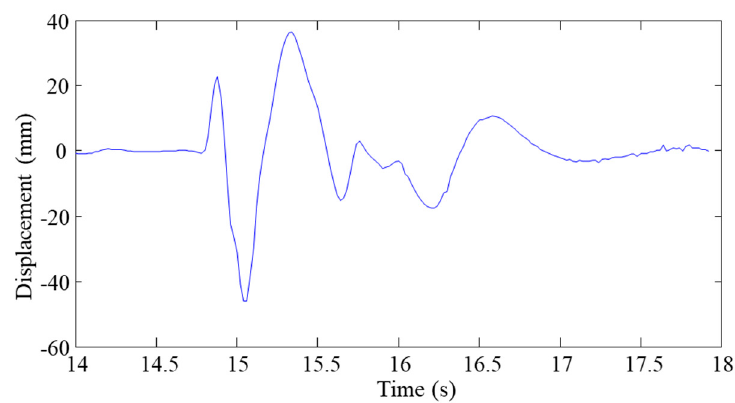
Figure 17. The displacement time history of isolation layer.